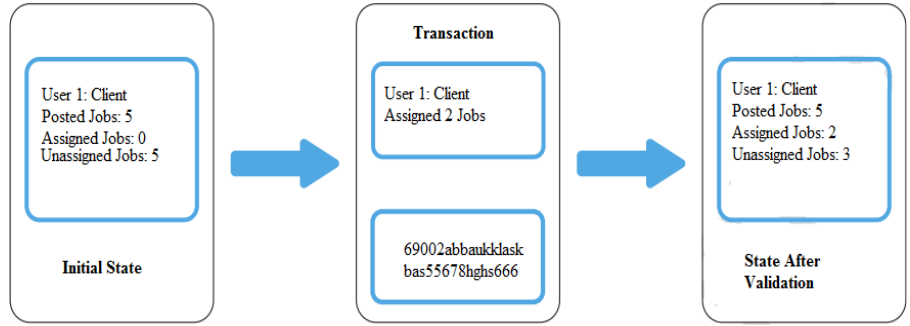
Figure 2. Validation phase of the transaction.